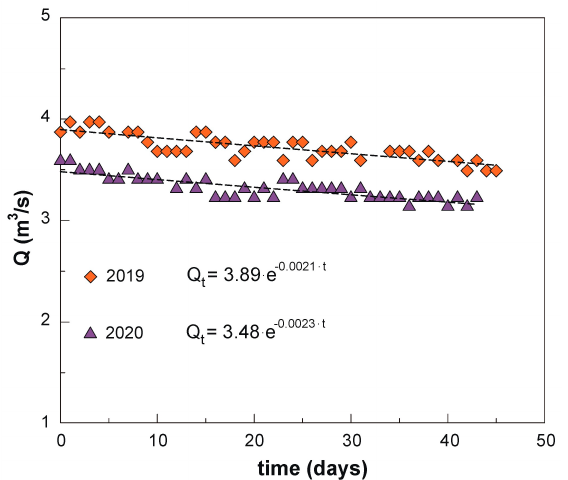
Figure 6. Recession curves for 2019 and 2020. Discharge data of the Nera River are recorded at sec- tion I1 (Figure